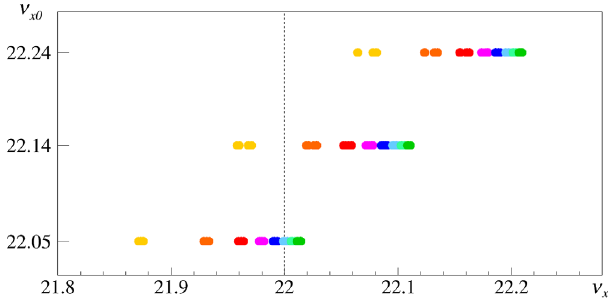
¼ 22 as is observed from Fig. 12. As the space-charge x does not induce odd-order resonances, it is considered that the integer resonance ν x ¼ 22 was excited by the sextupoles.